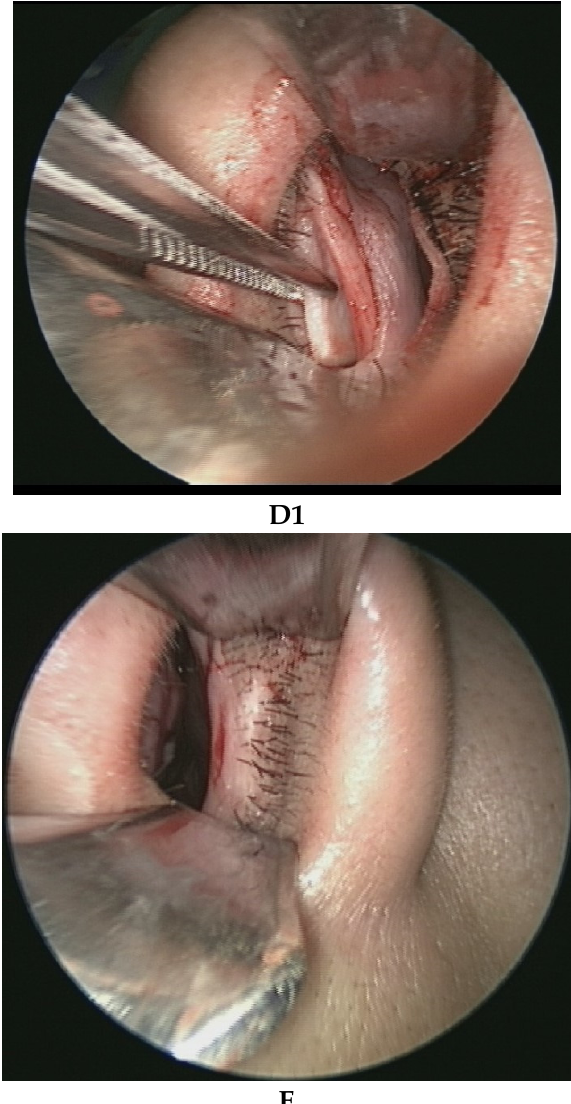
Figure 1. A step-by-step illustration of the surgical techniques used. Autologous septal cartilaginous batten grafts were reshaped and reconstructed in the concave side of the caudal nasal septum. As seen in Figure 1D1, the batten graft was reconstructed in the right (concave) side of the nose, and Figure 1D2 shows the batten graft as supported in the left (concave) side of the nose. The L strut cartilage was preserved for at least 1.0 cm from the caudal end and the connection between the septal cartilage, and the anterior nasal spine was also maintained. There were no incisions or wedge resections of the caudal nasal septum. The L-shaped caudal end and the cartilage batten graft were connected via through-and-through sutures with three stitches using 5-0 Prolene sutures in the concave side (Figure 1D2). Finally, the mucoperichondrial flaps were repositioned and 5-0 Vicryl simple sutures were used to close the incision wound (Figure 1E). Bilateral inferior turbinoplasty was also performed in all 26 studied cases. Absorbable nasal packing (nasopore) was packed bilaterally. Figure 2A1 shows the caudal septal deviation to the left side, and Figure 2B1 shows the right side. We reshaped and reconstructed the cartilaginous batten graft for the concave side (Figure 2A2,B2). We applied three stitches using through-and-through sutures to fix the batten graft and 5-0 Prolene sutures for the caudal end of the L strut. The nodes were fixed in the concave side (Figure 2A3,B3). When we performed surgery on the middle and posterior segments of the nasal septum, we used an endoscope. We also used an endoscope when we did inferior turbinoplasty.